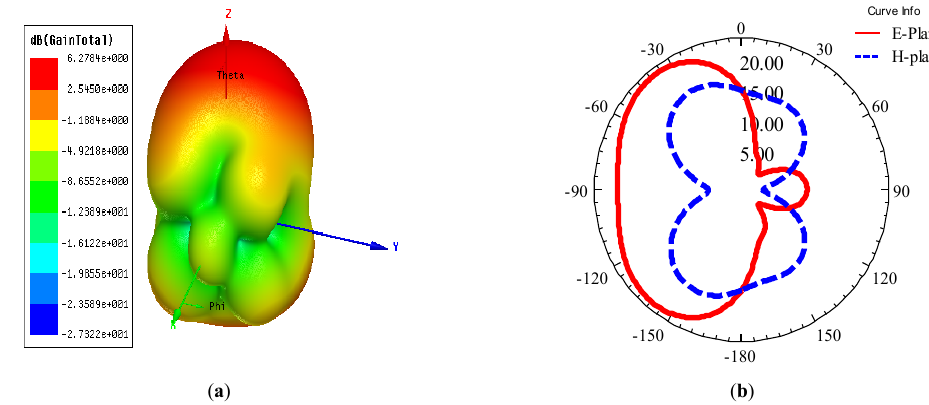
Figure 13. 3D gain, E- and H-fields of Slot antenna 3 at 2450 MHz: phi = 0°; 90°. ( a ) 3D gain at 2450 MHz; ( b ) E- and H-fields at 2450 MHz: phi = 0°; 90°.